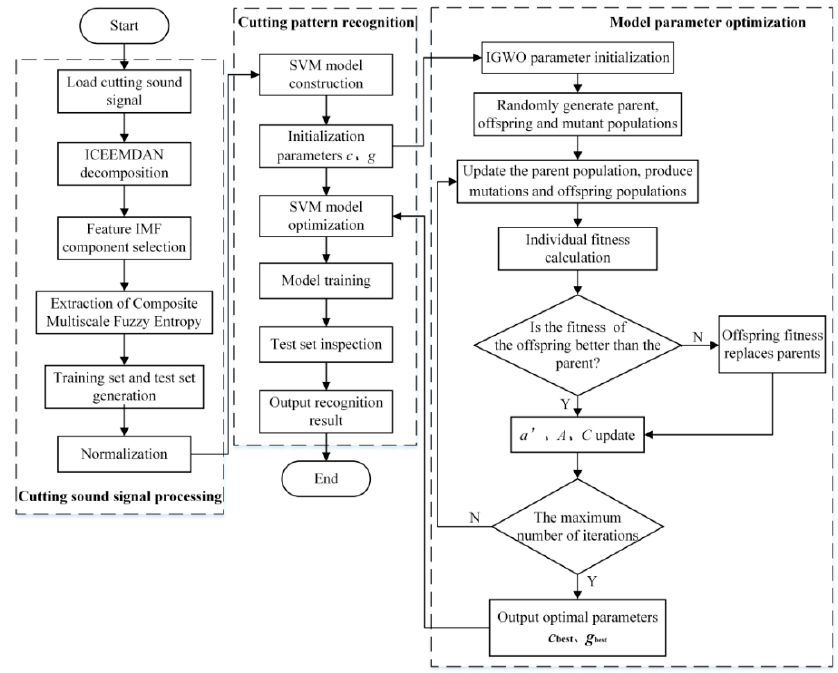
Figure 2. Flow chart of the cutting pattern recognition model.